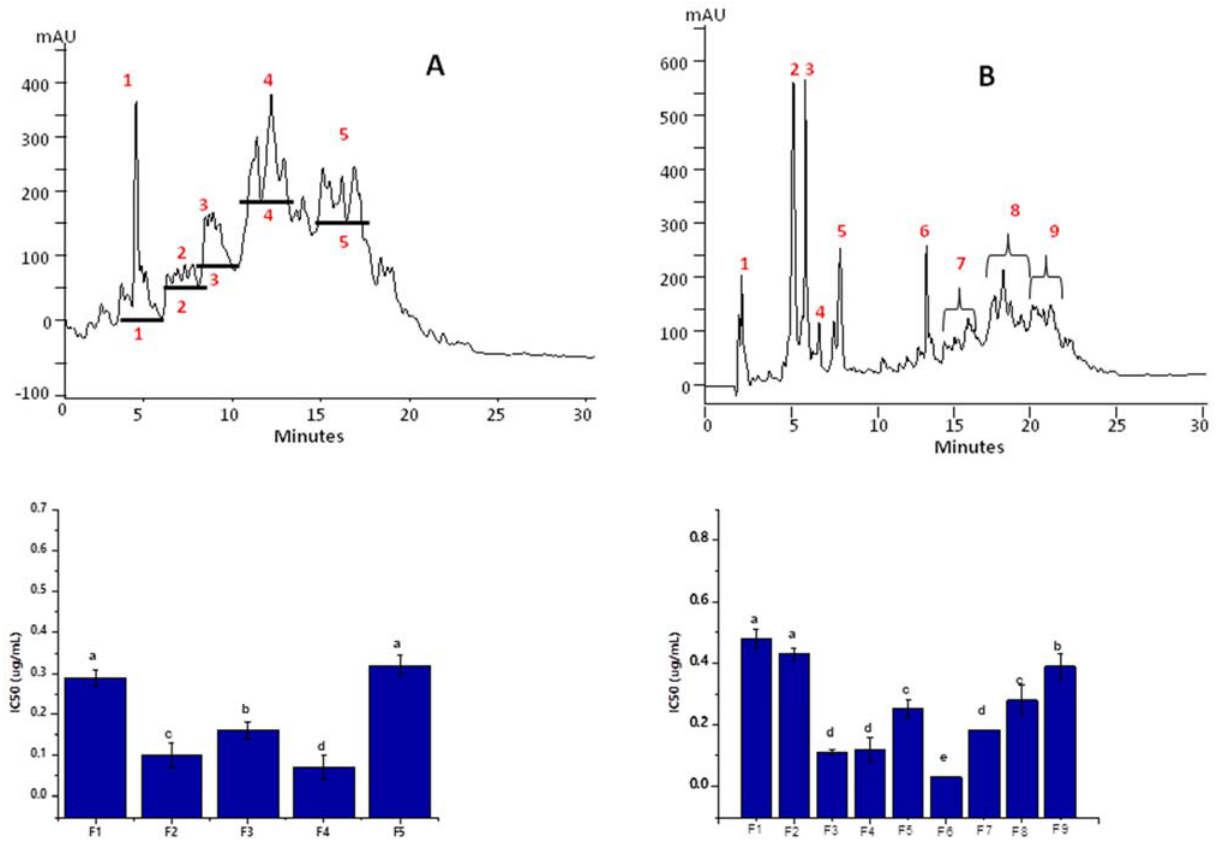
Figure 3. Elution profiles of Alc_M60min_F3 and Pap_E240min_F3 fractions by RP-HPLC and the ACE-inhibitory activity of each sub-fraction; ( A ) Alc_M60min_F3, ( B ) Pap_E240min_F3. Red numbers in the chromatograms indicate the peptides’ sub-fractions F1-F5 of Alc_M60min_F3 and F1-F9 of Pap_E240min_F3. Statistical difference ( p < 0.05) is denoted by letters a–c. Shared letters indicate no significant difference.